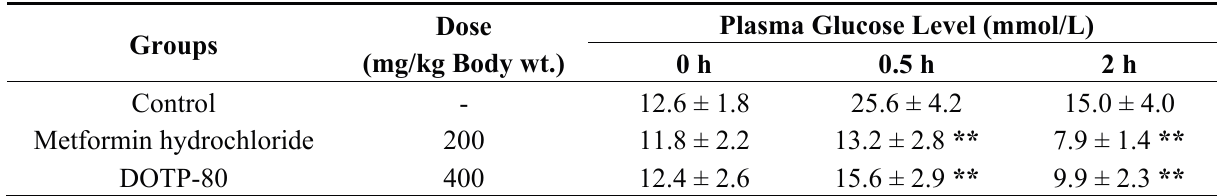
Table 3. Effect of DOTP-80 on glucose tolerance of alloxan-induced rats